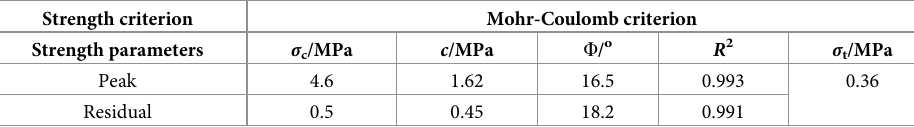
Table 1. Mudstone strength parameters.